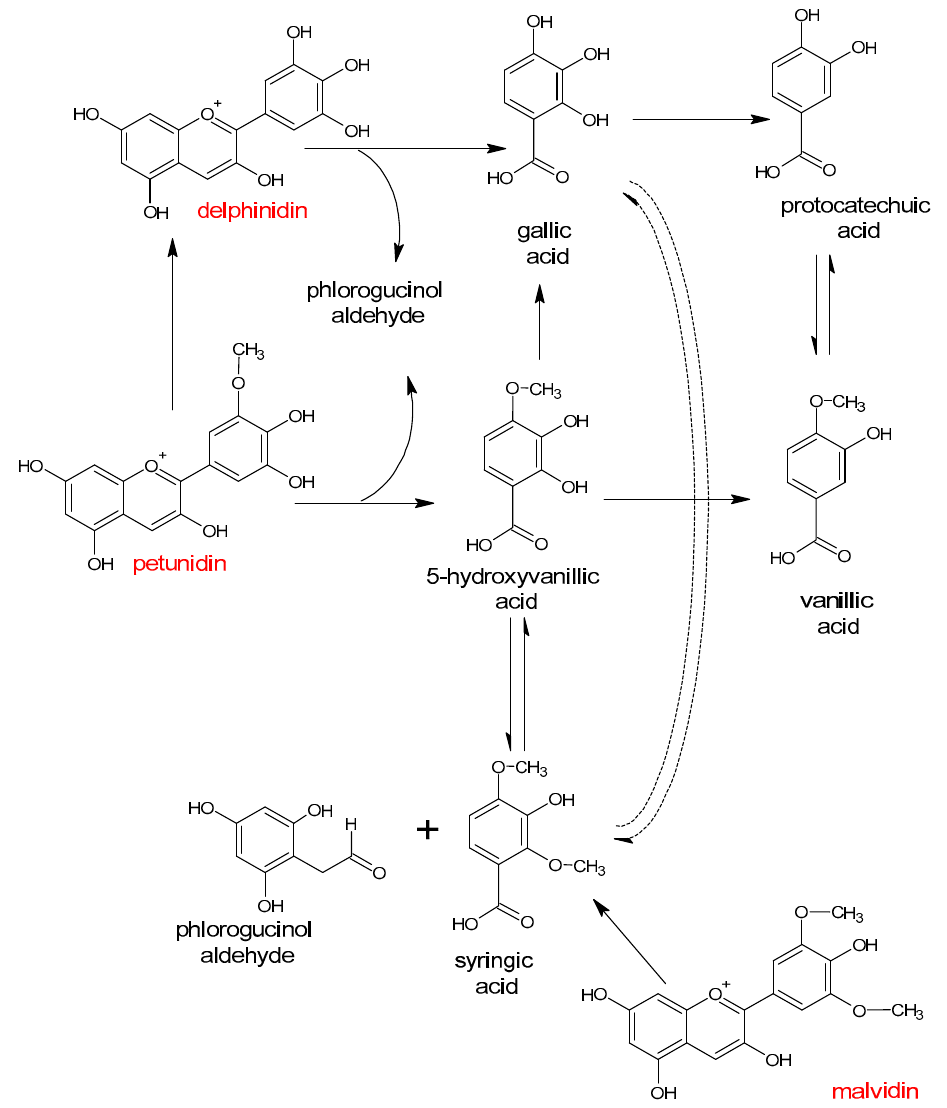
Figure 15. Biodegradation of malvidin, delphinidin and petunidin by intestinal bacteria. Based on